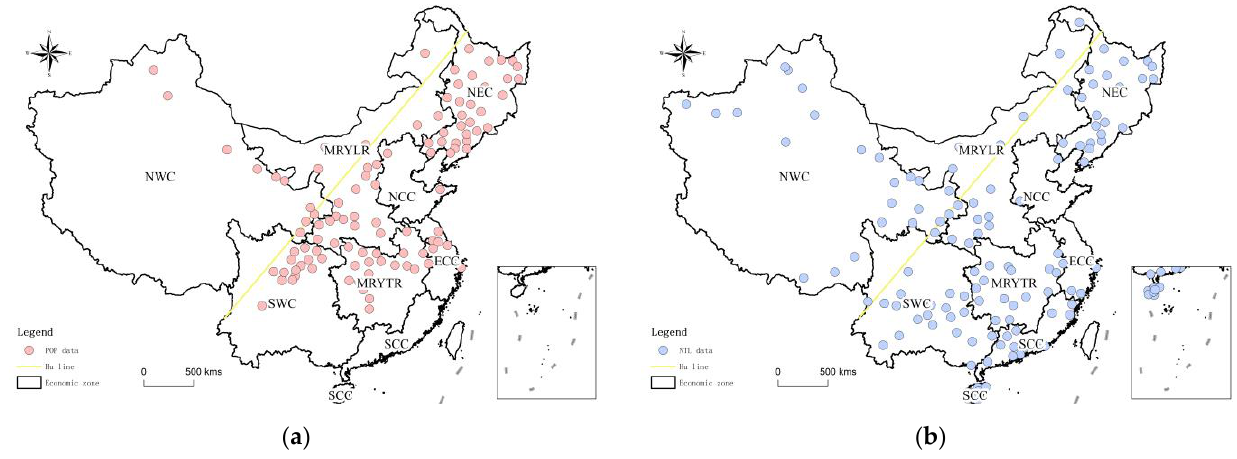
Figure 8. ( a ) Shrinking cities identified based on population datasets; ( b ) shrinking cities identified based on NTL.